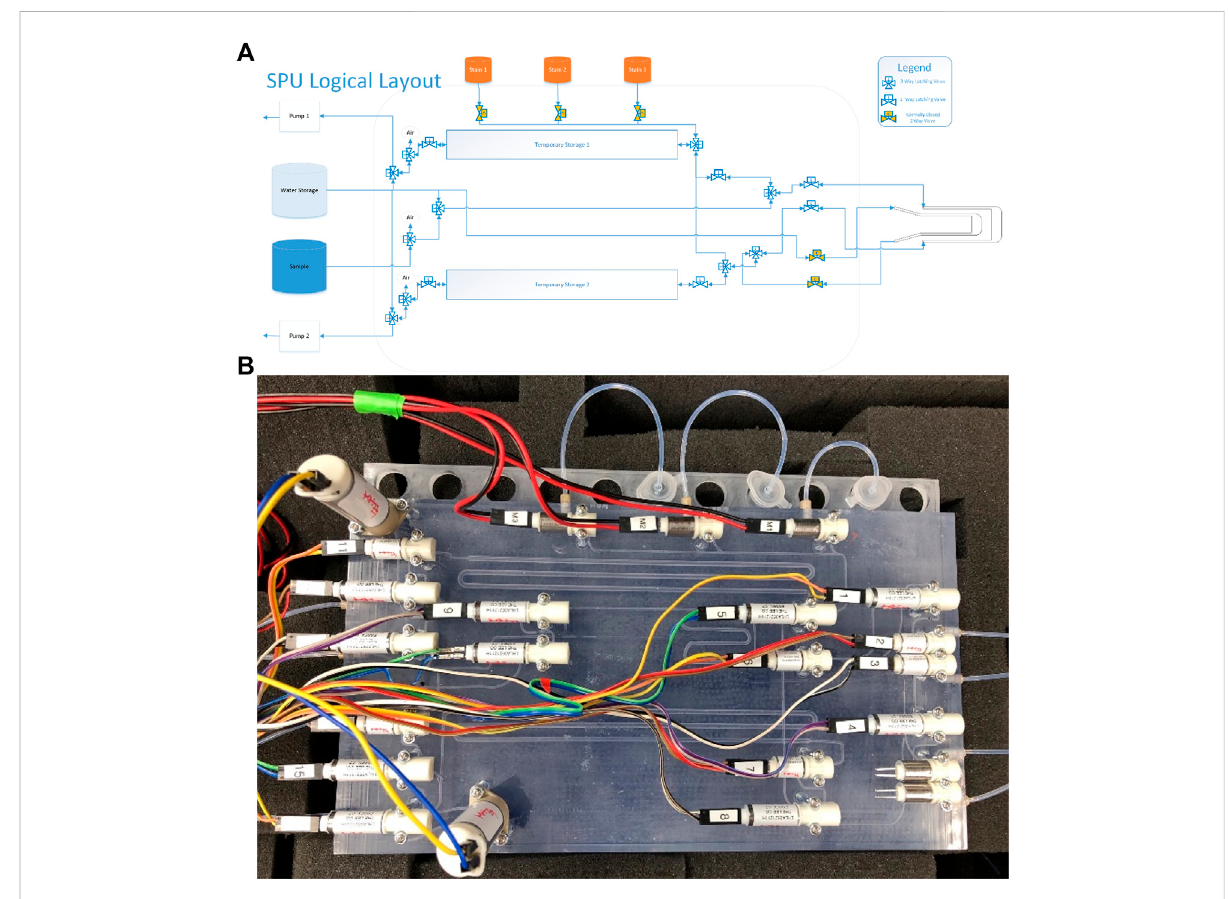
FIGURE 3 Sample Processing Unit. (A) Image of the SPU in schematic view connected to the SAC. The SPU consisted of 10 three-way latching valves, six two-way latching valves, and fi ve normally closed solenoid valves. Fluid motion through the system was accomplished via coordinated action of pump choice and valve state. Latching valves were used where their state lasted for extended periods. Normally closed solenoid valves were used where preventing fl uid motion the majority of the time was important. (B) A top-down view of the SPU: The SPU was 3D printed using a clear polymer marketed as Watershed (Protolabs, Maple Plain, MN). Not shown, the SAC was connected to the right side via